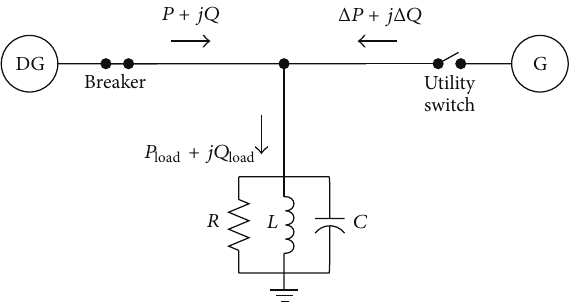
Figure 2: DG system configuration and power